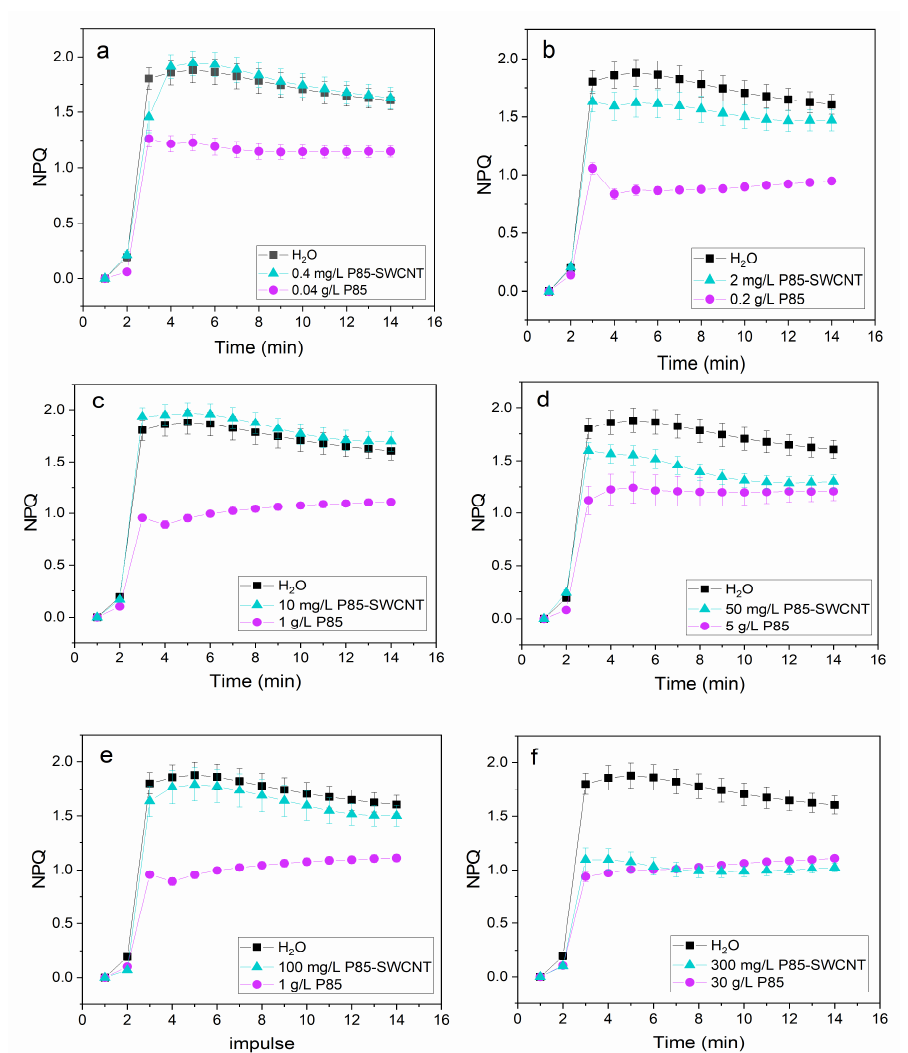
Figure 5. Traces of NPQ kinetics recorded for 14-day old plants developed from hydro-, P85-SWCNT-, and P85-primed seeds. Data for 0.4 mg/L ( a ), 2 mg/L ( b ), 10 mg/L ( c ), 50 mg/L ( d ), 100 mg/L ( e ) and 300 mg/L ( f ) P85-SWCNT (triangles), as well as the corresponding P85 treatments (circles), are presented in different panels. For clarity each panel contains data for hydro-primed samples (squares) as well. Mean ± SE. For further experimental details, see Materials and Methods.